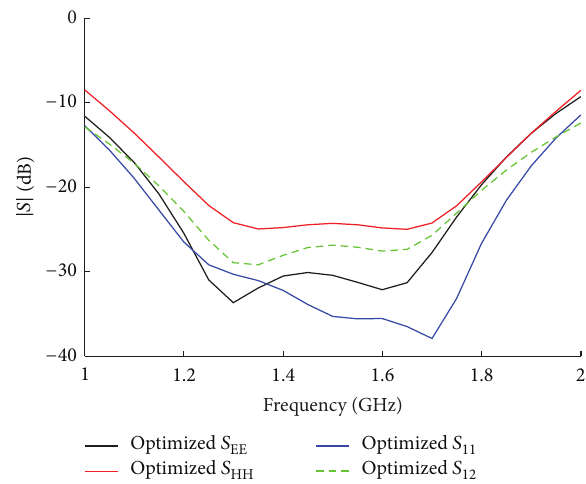
Figure 5: The optimized scattering parameters of the